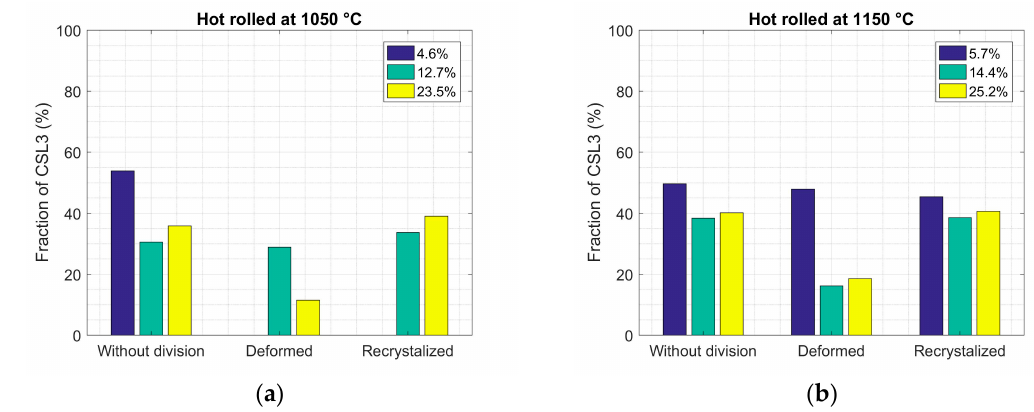
Figure 4. Fraction of CSL3 boundaries without division, in deformed and recrystallized grains for plates hot rolled at 1050 °C ( a ) and 1150 °C ( b ) with different deformation level.